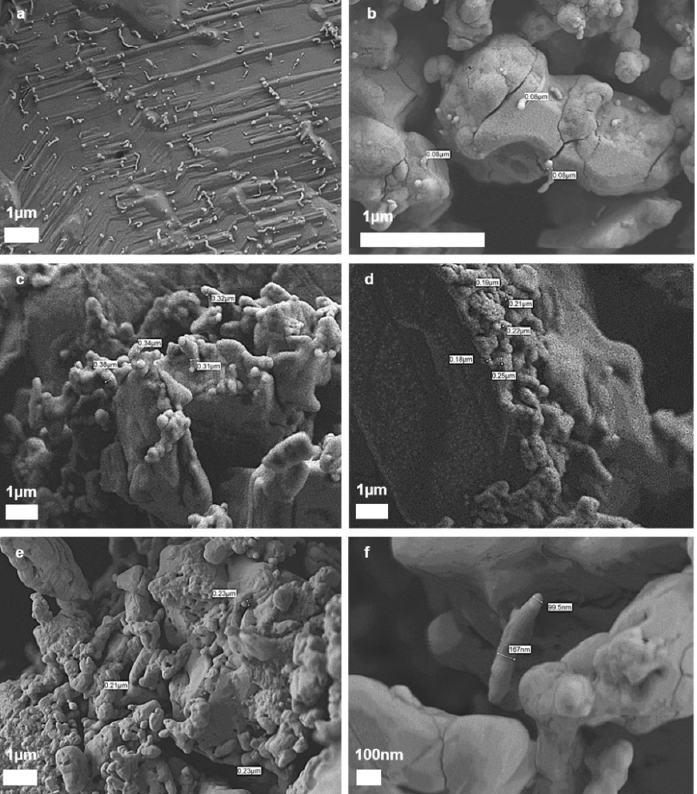
Figure 7. Cryo-SEM of MWCNT ( a , b ); MWCNT/PANI conjugates ( c , d ); MWCNT/PANI conjugates doped with Ag + or Cu 2+ ( e , f ).